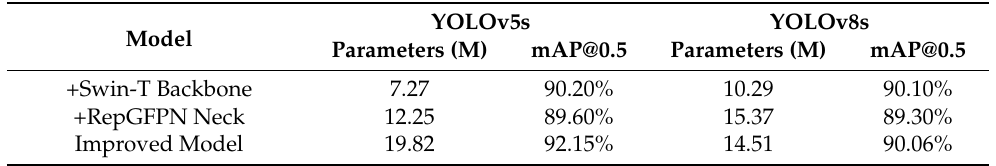
Table 7. Comparison of improved YOLOv5s and YOLOv8s.